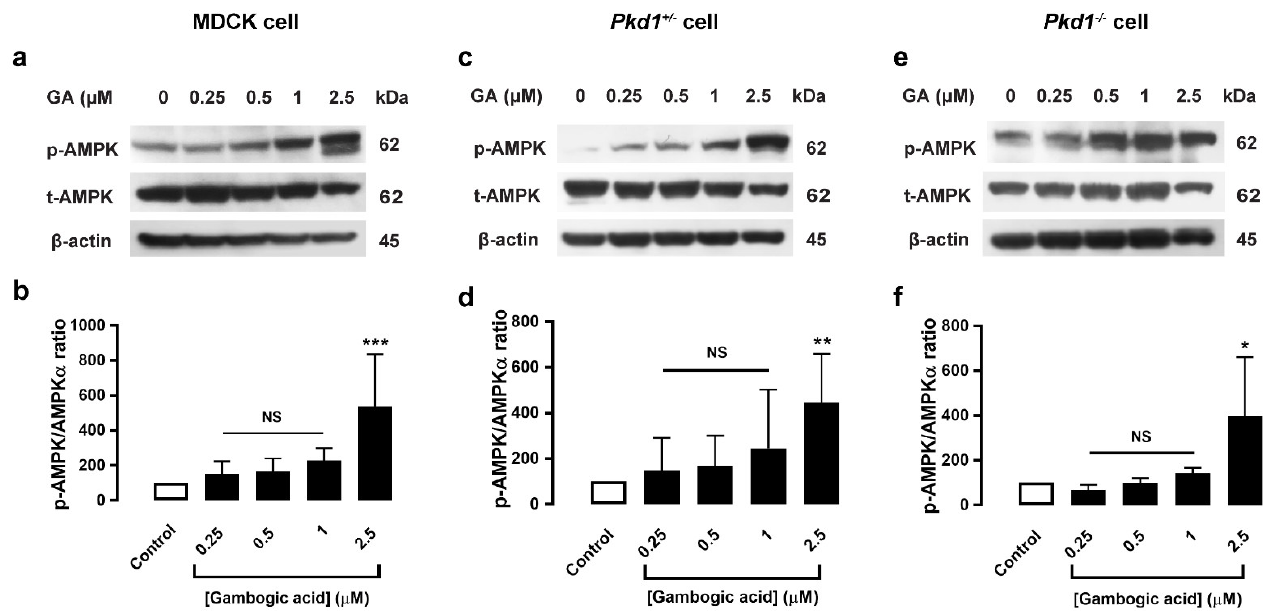
Figure 4. Effect of gambogic acid on AMPK protein expression in MDCK and Pkd1 mutant cell monolayers. Cells were seeded in a petri-dish (60 × 15 mm) and grown for 24 h. MDCK cells ( a ), Pkd1 − / − cells ( c ), and Pkd1 + / − cells ( e ) were incubated with DMSO (control), or GA at doses of 0.25, 0.5, 1, and 2.5 μM for 24 h, and were blotted with the indicated antibodies. The representative band intensity of protein expression is shown. Densitometric analysis of p-AMPK/AMPKα expression was normalized to β-actin and is shown as a graph of MDCK cells ( b ), Pkd1 + / − cells ( d ) , and Pkd1 − / − cells ( f ), respectively (six independent experiments, mean of % control ± SEM, n = 6, * p < 0.05, ** p < 0.01, ** * p < 0.001, NS; not significant).